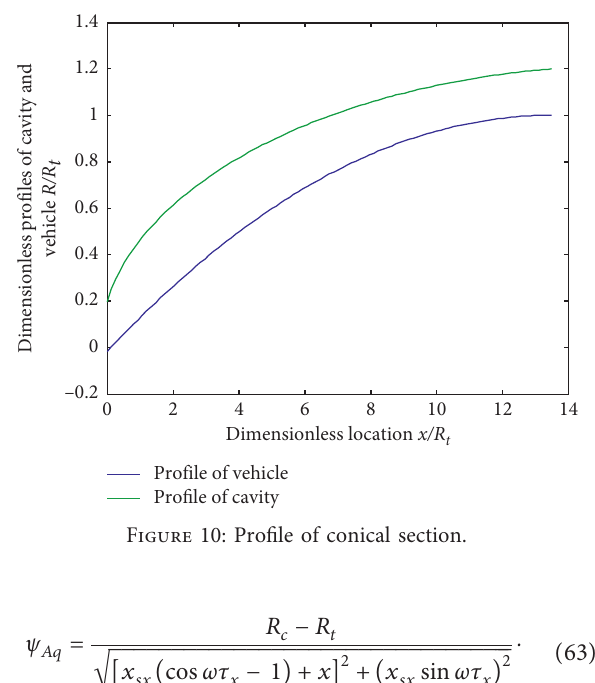
Figure 10: Profile of conical section.